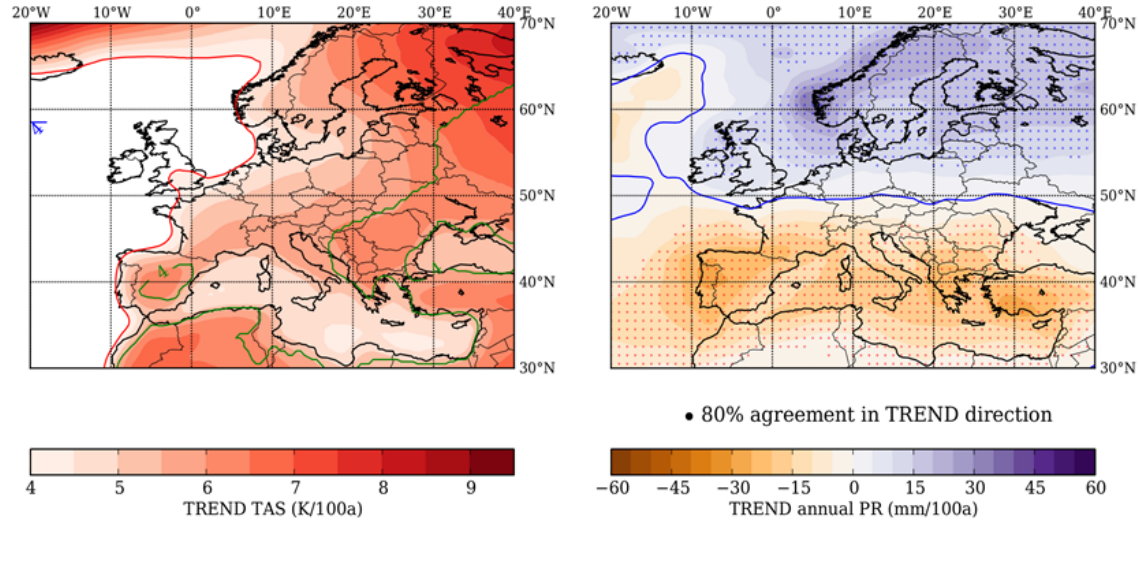
Figure 11. Context view of projected European temperature and precipitation distributions [43]. (copyright Peter Hoffmann,